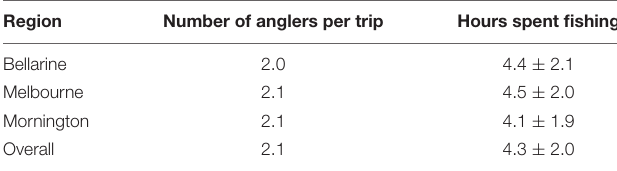
TABLE 2 | The average number of anglers per trip and average ( ± SD) time spent fishing per trip in Port Phillip Bay by residential regions and